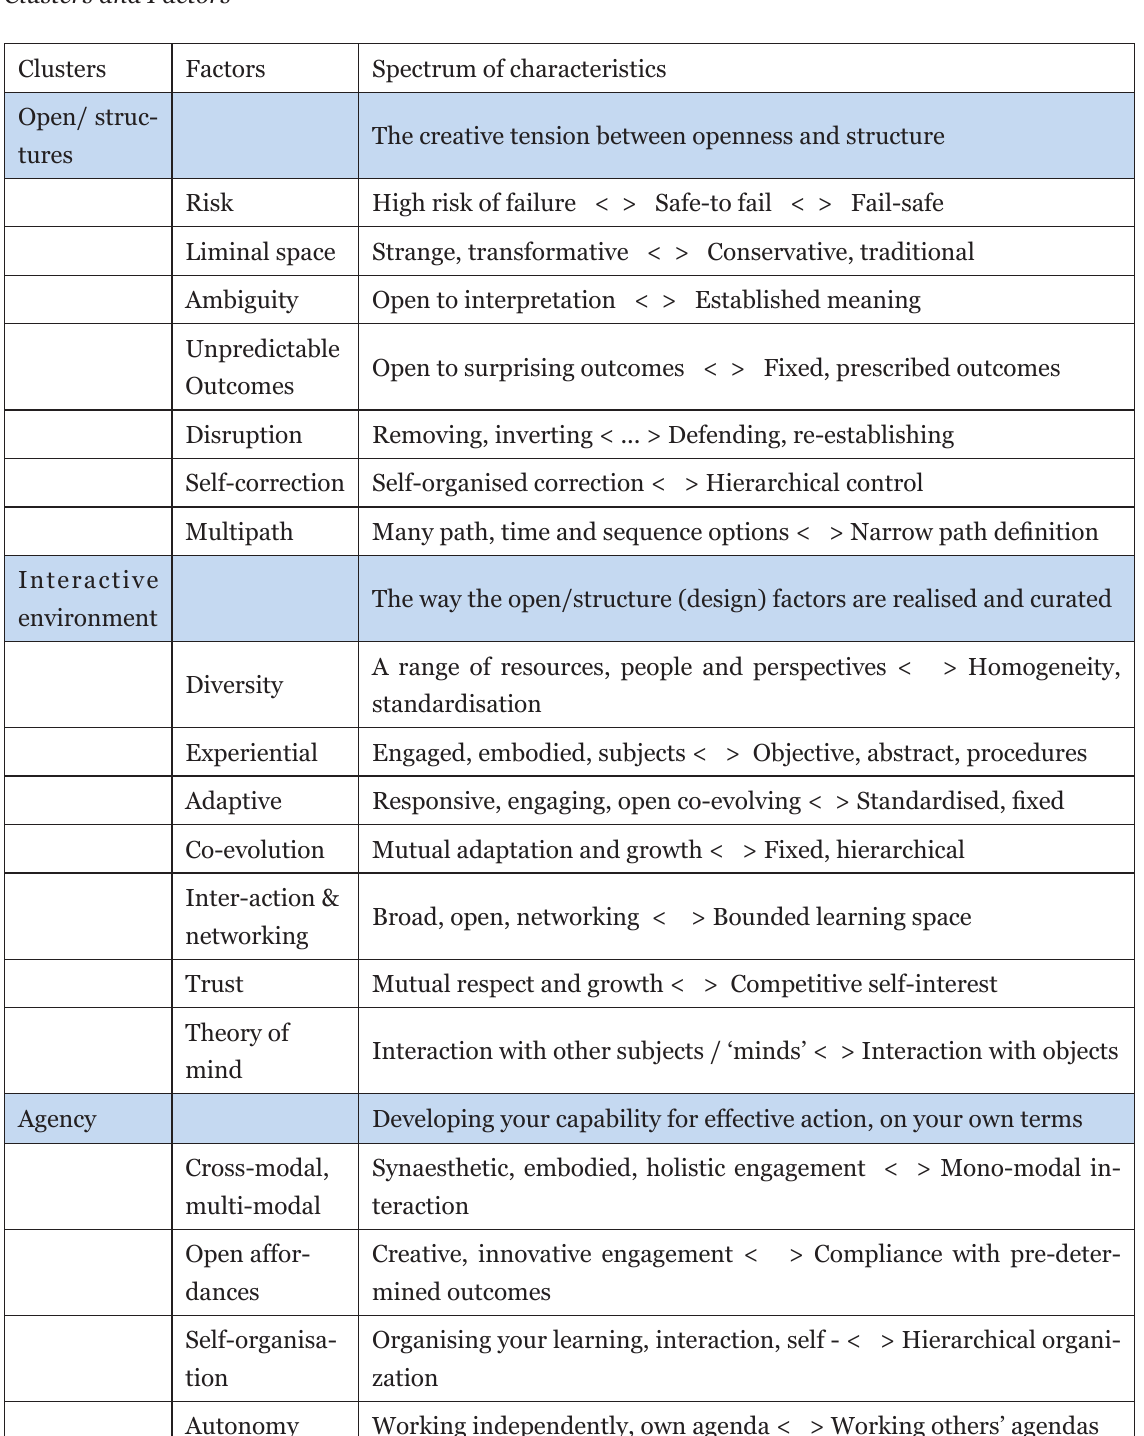
Table 2 Clusters and Factors Clusters Factors Spectrum of characteristics Open/